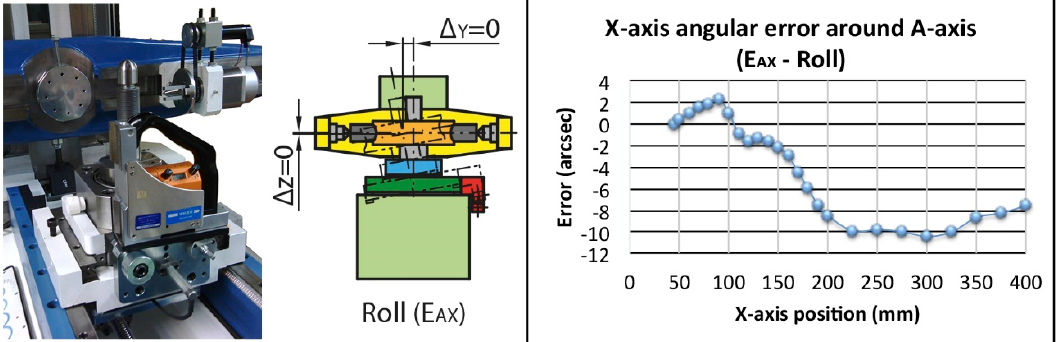
Figure 9. Roll error (E AX ) and location of electronic level in the measurement.